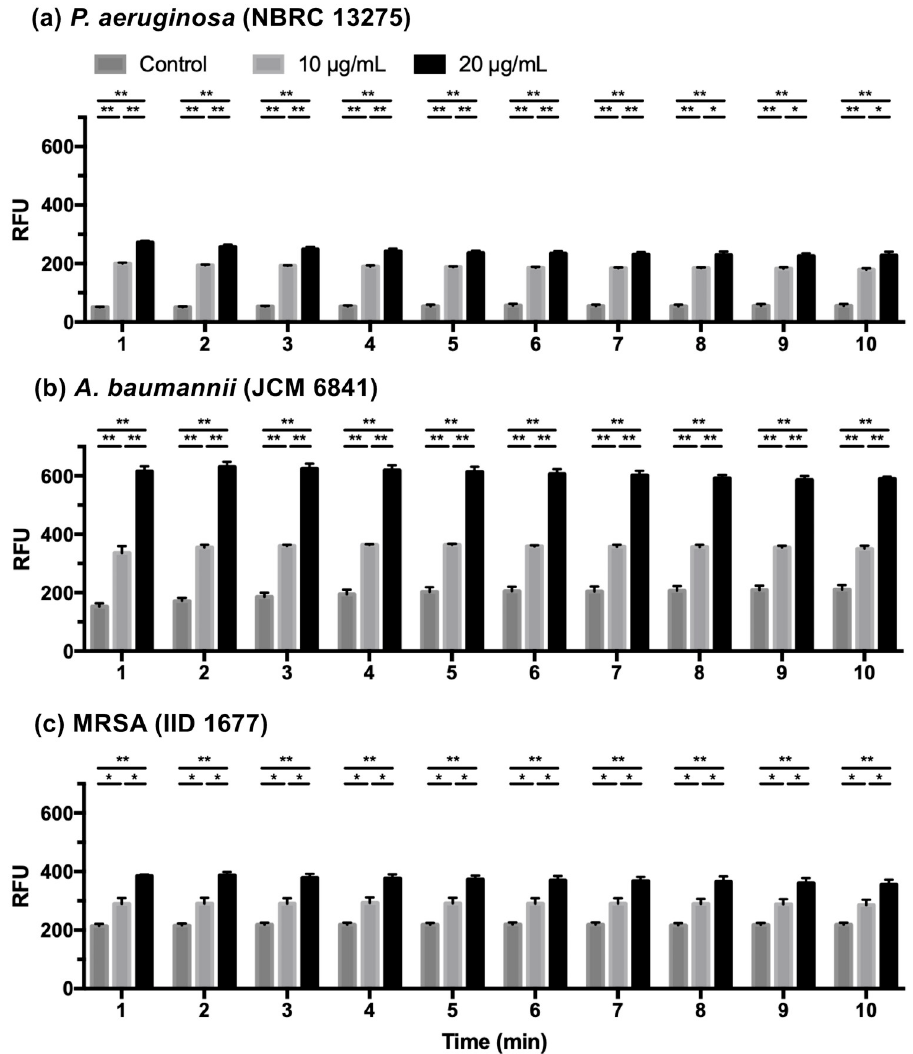
Fig 4. NPN assays. The outer membrane permeability of the gram-negative bacteria and plasma membrane permeability of MRSA were determined by NPN assays. (a) Pseudomonas aeruginosa (NBRC 13275), (b) Acinetobacter baumannii (JCM 6841), (c) MRSA (IID 1677). The values are the mean ± SEM. Three independent experiments were performed for each type of bacteria in the control solution and at each concentration of LYZOX. � p < 0.05, �� p < 0.01 (unpaired t-test). RFU: relative fluorescence